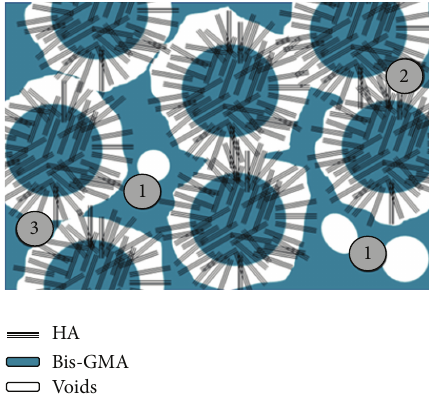
Figure 7: Three-dimensional structure of the HA-Bis-GMA com- posite.